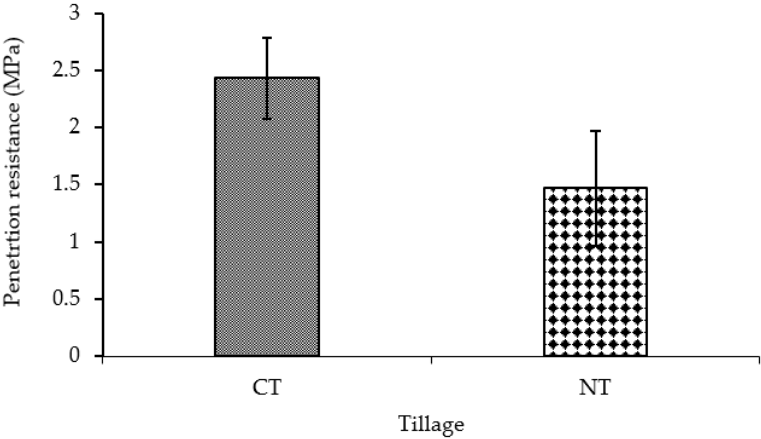
Figure 2. E ff ects of tillage on to penetration resistance at the 0–0.15 m depth after 3 years of cropping. CT is conventional tillage and NT is no-till. Error bars indicate standard deviation.